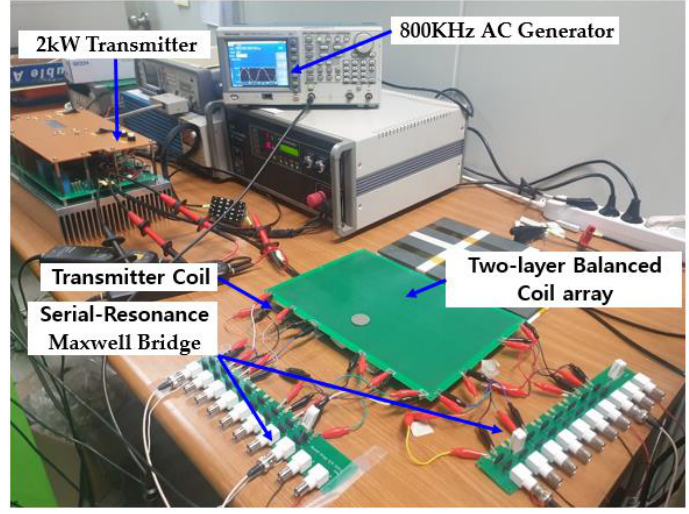
Figure 8. Proposed system and test environment.